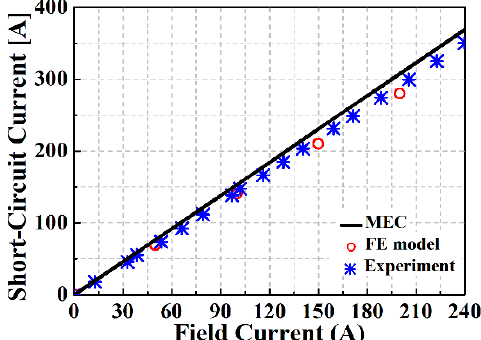
Figure 13. Comparison of short-circuit current values as the field current changes.